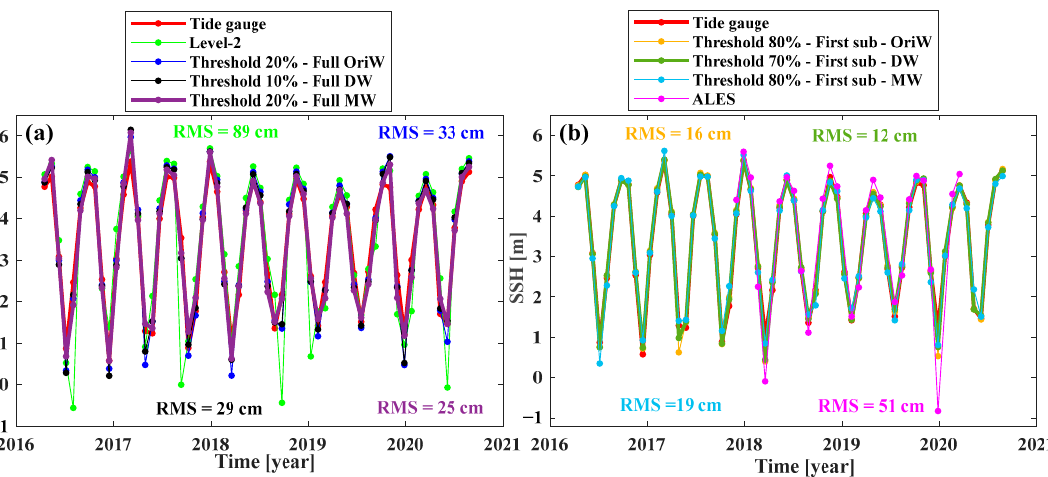
Figure 17. Water level time series of the Bay of Biscay pass 216 based on our waveform retracking scenarios and ALES dataset in front of tide gauges, ( a ): full-waveform and ( b ): sub-waveform.